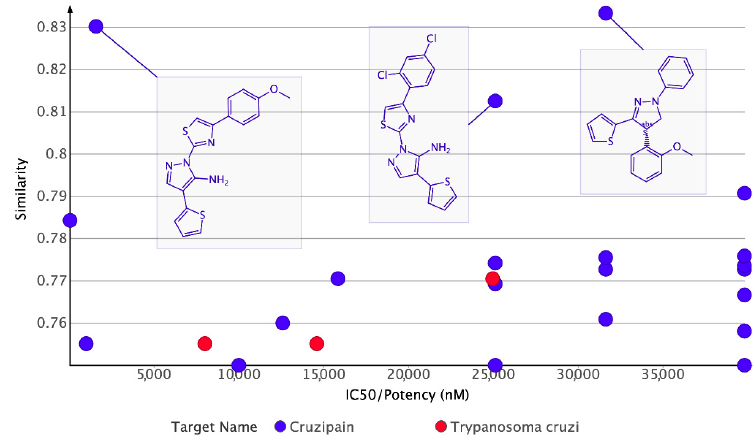
Figure 9. In silico analysis of pyrazole-thiazoline scaffolds using fragment-based search of molecular targets. The image shows matched scaffolds of pyrazole-thiazoline to trypanocidal compounds with different IC 50 (nM) against annotated targets in the ChEMBL database. The analysis was performed using DataWarrior software, and three inhibitors of cruzipain were retrieved with similarity to pyrazole-thiazoline derivatives.